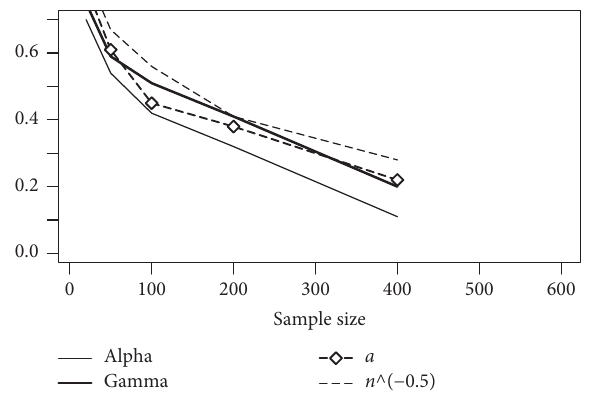
Figure 5: Simulated average absolute errors for MLEs ( 􏽢 α , 􏽢 c , 􏽢 a ). Table 5: Simulation results of the actuarial measures at different levels of significance for α � 1 . 9, c � 0 . 4, and a � 0 . 9. Distribution